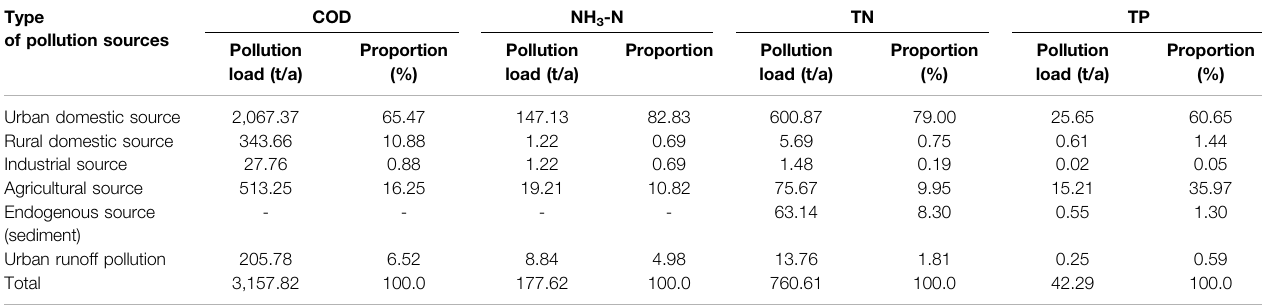
TABLE 6 | Amount of pollutants entering the reservoir and its contribution proportion around the Zhangze